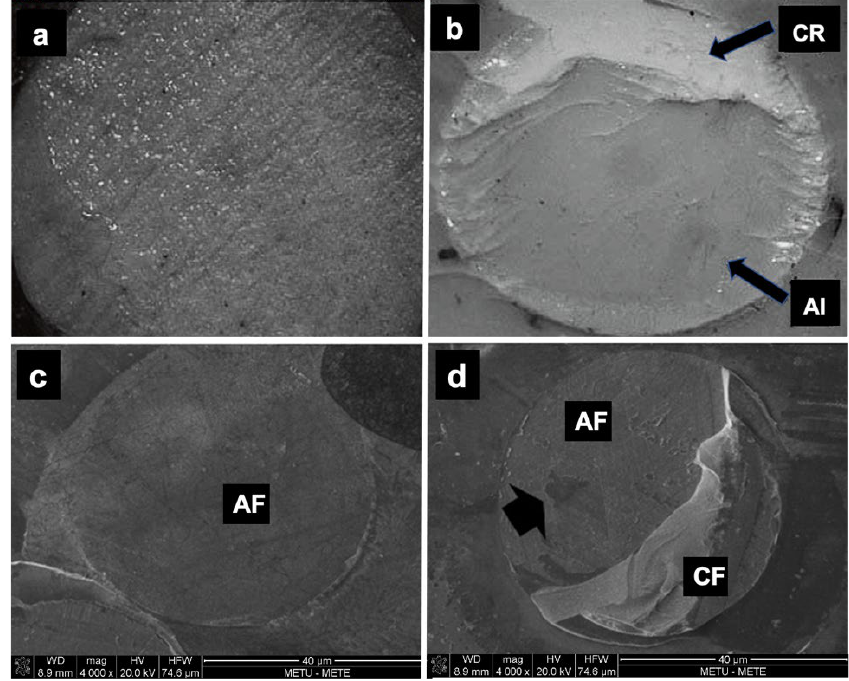
Figure 4. The light microscopy images of failure modes (40×): ( a ) adhesive failure; ( b ) mixed failure. CR: composite resin; AI: adhesive interface. The scanning electron microscope images (×100 magnification) of failure modes: ( c ) adhesive failure; ( d ) mixed failure. AF: adhesive failure; CF: cohesive failure.